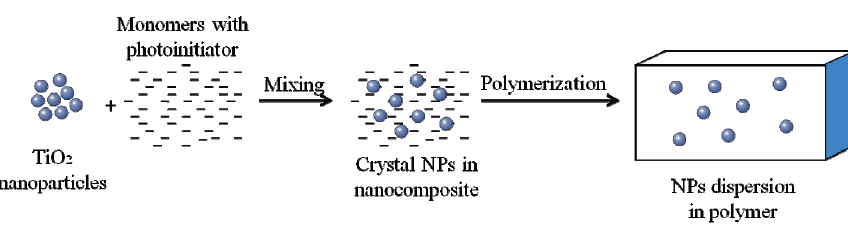
Figure 2. Ex situ synthesis schemes for the preparation of